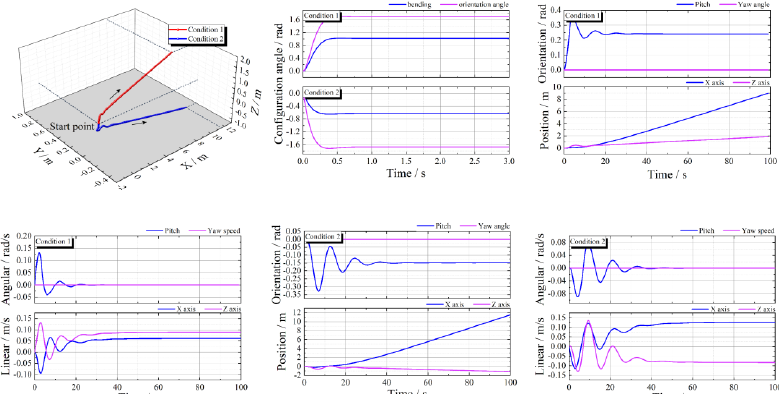
Figure 11. Simulation tests for yaw turning motion under different conditions, which contain the trajectories under conditions 1 and 2, configurations of soft joints, position and orientation under condition 1, linear and angular velocity under condition 1, position and orientation under condition 2, and linear and angular velocity under condition 2.